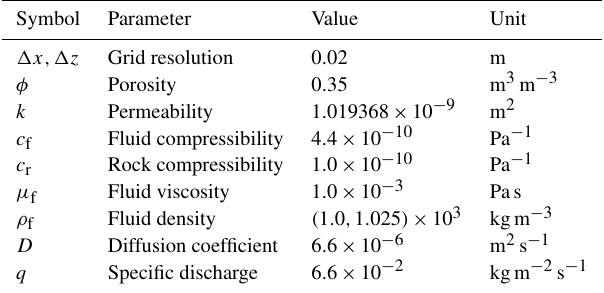
Table 1. Henry problem model parameters adapted from Kolditz et al.